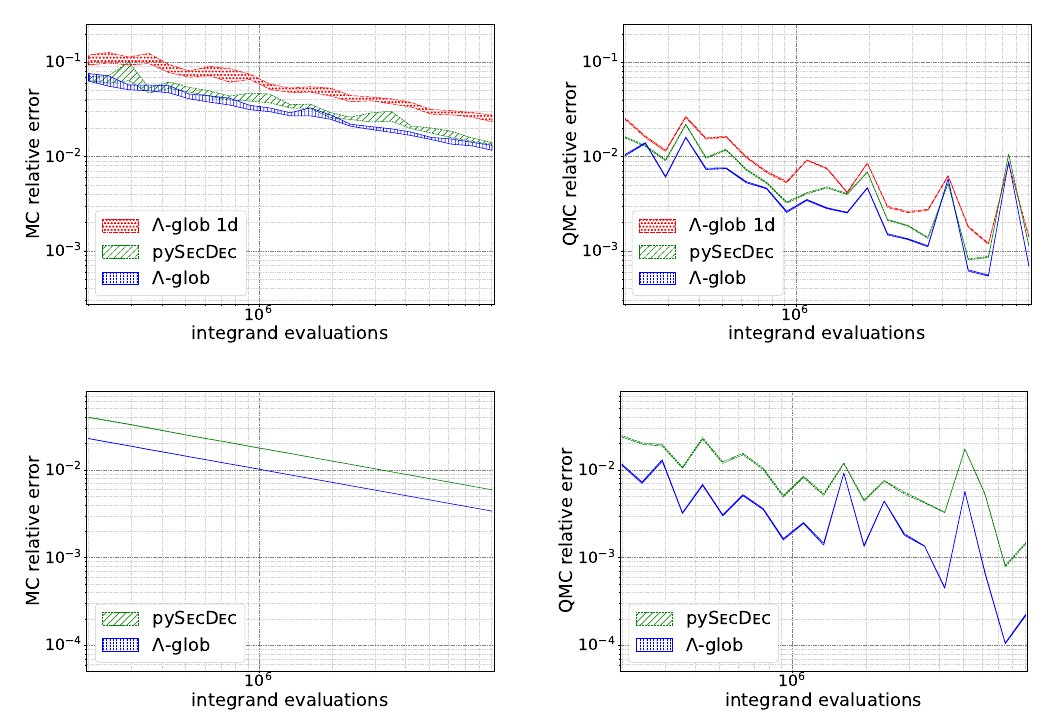
Figure 4: Monte Carlo (left) and Quasi Monte Carlo (right) integration errors for the first sector of the ladder2L example (upper) and the elliptic2L example (lower). For the ladder2L diagram we show the 1-dimensional and n -dimensional λ -selections using Λ -glob; for the elliptic2L diagram these two turn out to be the same, so only one is